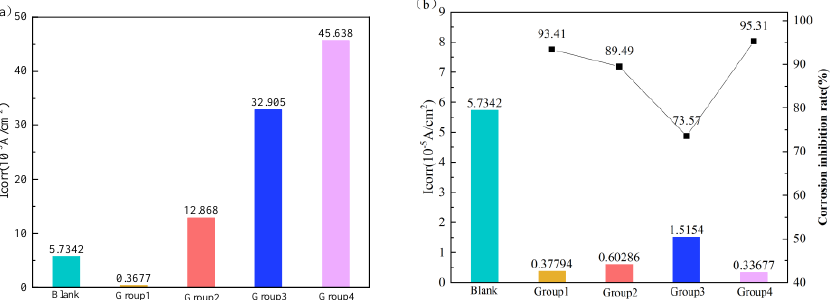
Figure 10. Self-corrosion current density and inhibitor efficiency of P110ss steel corroded in system one and 2. ( a ) System one; ( b ) system two.